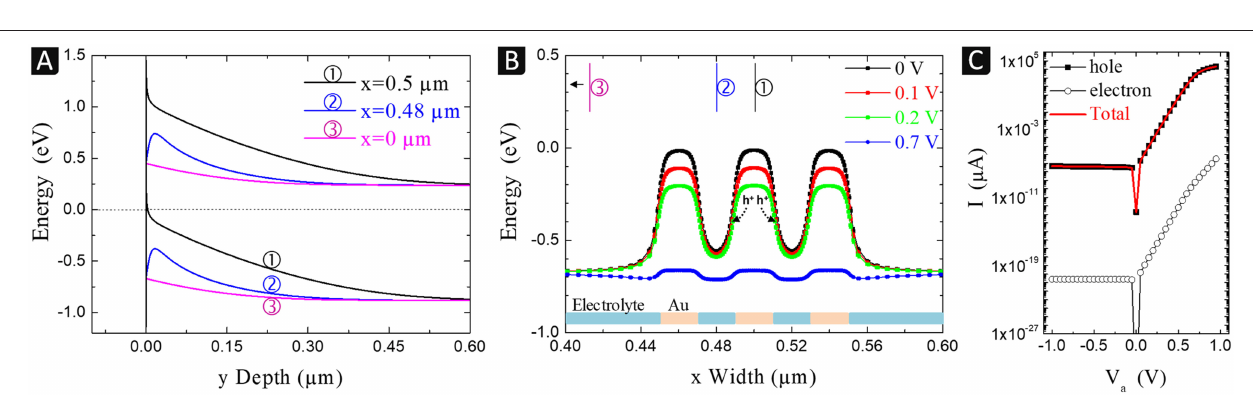
FIGURE 9 | Simulations of: (A) the band bending of n-Si/Au and n-Si/electrolyte junctions with cut-lines (y Depth) corresponding to a gold pad center (x = 0.5 µ m), an electrolyte contact between two gold pads (x = 0.48 µ m) and the electrolyte far from gold (x = 0 µ m); (B) lateral modulations (x Width) of the valence band energies at 3nm beneath the silicon surface, at 0V (equilibrium) and under 0.1, 0.2, and 0.7V bias applied to the gold contacts ( cf. Supplementary Information ); (C) I-V characteristics of the Au/n-Si/Electrolyte